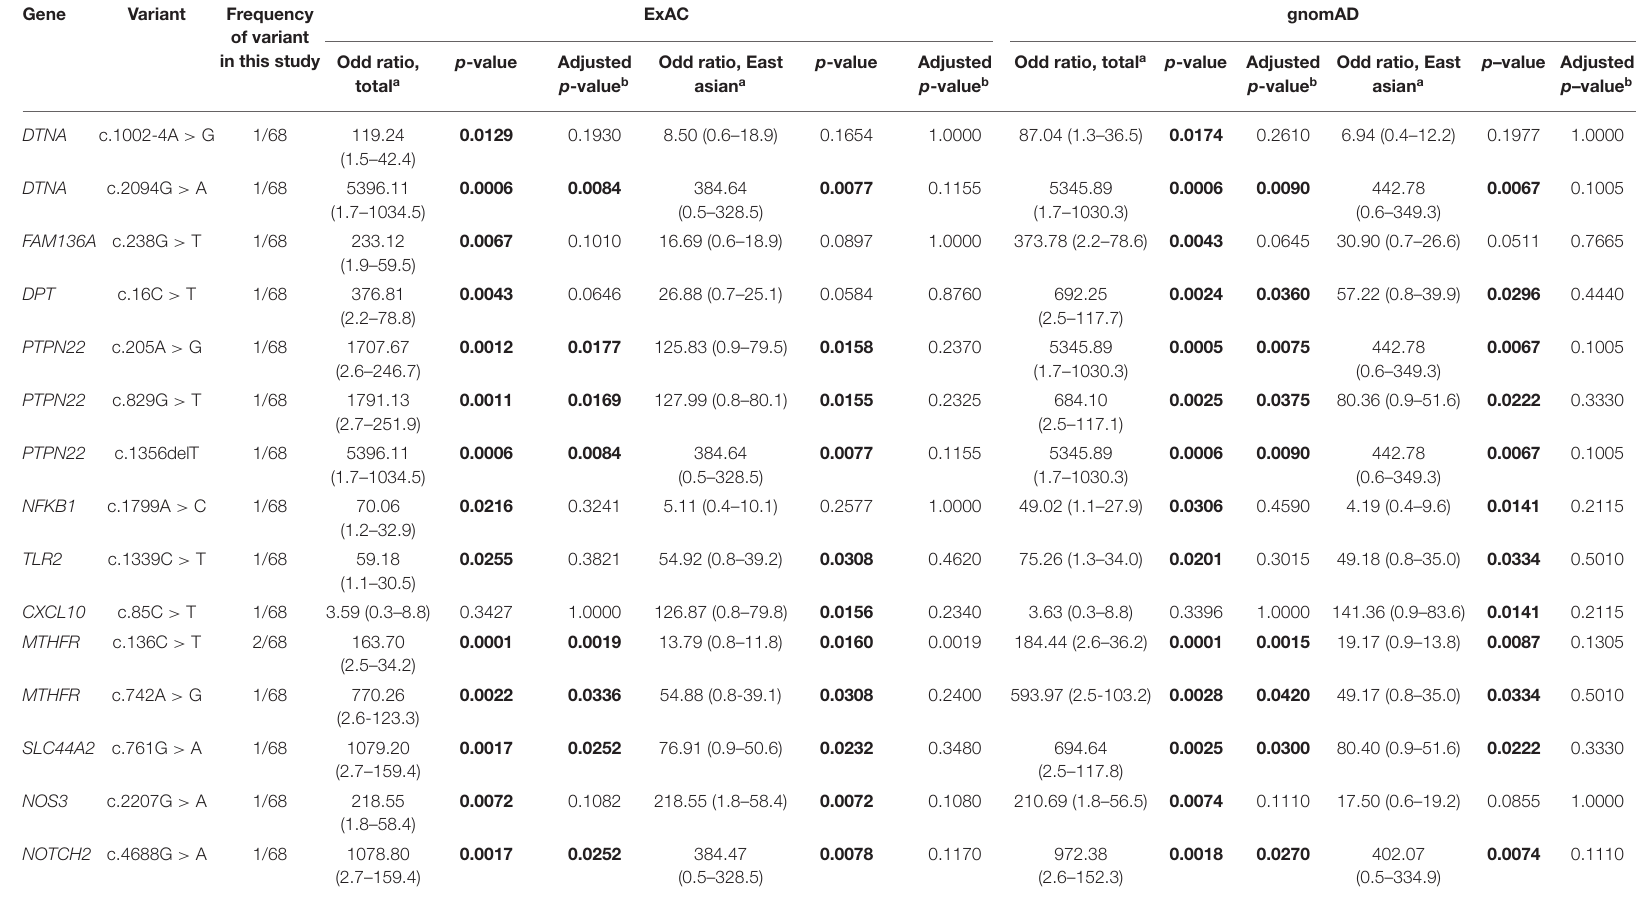
TABLE 2 | Genetic association analysis results for rare